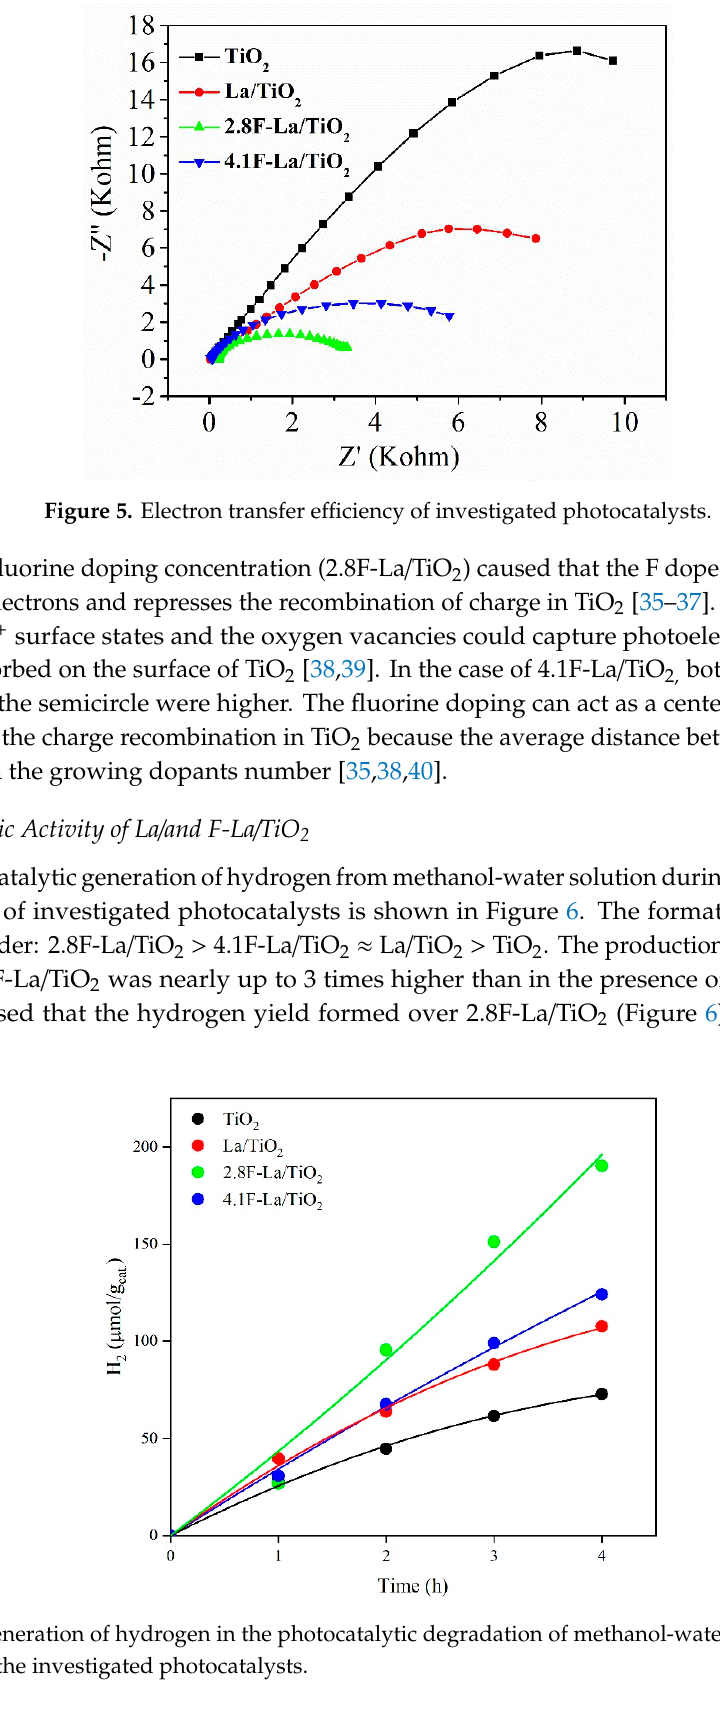
Figure 6. Generation of hydrogen in the photocatalytic degradation of methanol-water solution in the presence of the investigated